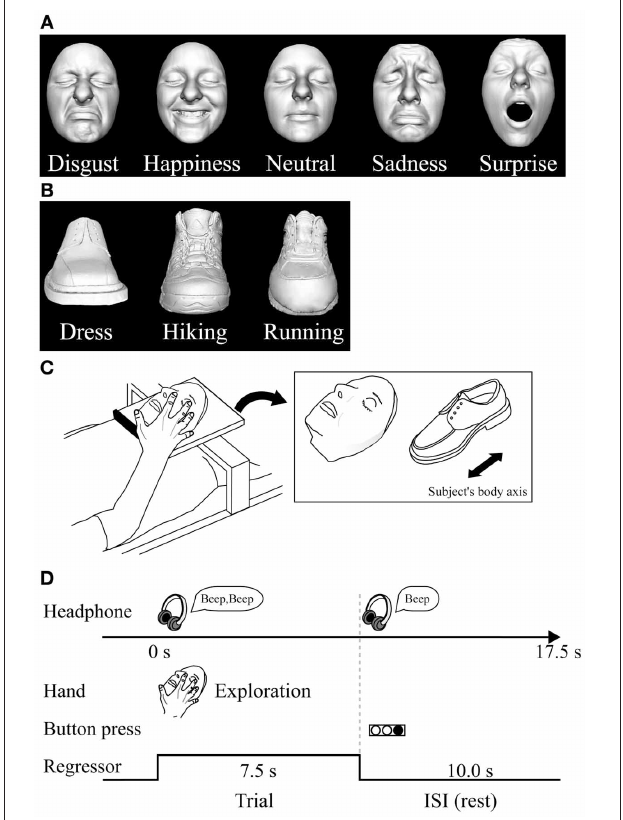
FIGURE 1 | Haptic task. (A) Plastic masks, each portraying five different expressions, were utilized as stimuli in the psychophysical experiment. (B) The fMRI experiment used plastic masks expressing disgust, happiness, and neutral; three types of shoe (plastic casts) were used as control objects. (C) In the fMRI experiment, each exemplar was mounted on a plexiglass table. The orientation of the objects as they were presented on the table is shown on the right. (D) Task schedule for the fMRI experiment. Subjects were instructed to explore the object with their right hand immediately after they heard a sound cue though headphones. When another sound cue was presented (after 7.5s of exploration), the subjects were told to stop. They were instructed to respond immediately by using their left hand to press the button corresponding to the appropriate numeric code for the subordinate-level category presented. Neural activity during the task block was modeled with a box-car function for each object category (i.e., face and shoe). The regressor shown was convolved with a canonical